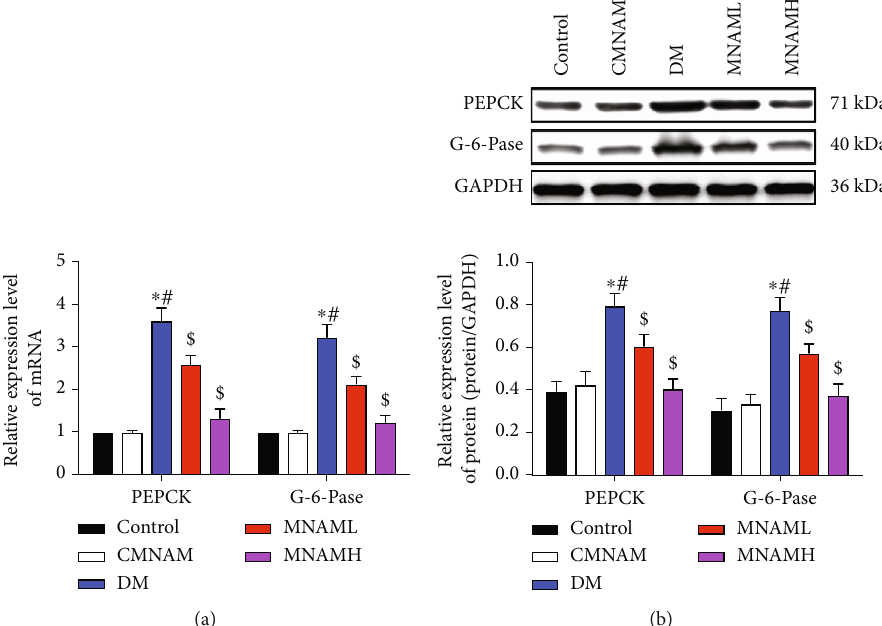
Figure 4: MNAM reduces gluconeogenesis in the liver of obese T2DM mice ( n = 10 ). (a) Real-time PCR was used to detect the mRNA expression of Pepck and G-6-Pase in the liver tissue of each group; (b) the expression of PEPCK and G-6-Pase in the liver of mice detected by Western blot. ∗ Compared with the control group, P < 0 : 05 ; # compared with the CMNAM group, P < 0 : 05 ; $ compared with the DM group, P < 0 : 05